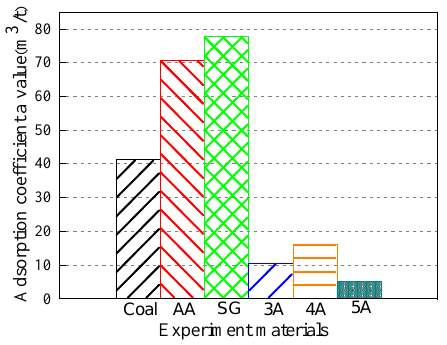
ffi cient a value of testing materials in constant Figure 8. Adsorption coefficient a value of testing materials in constant factors. Figure 8. Adsorption coe